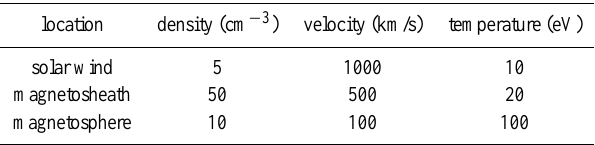
Table 1. Electron parameters used in the